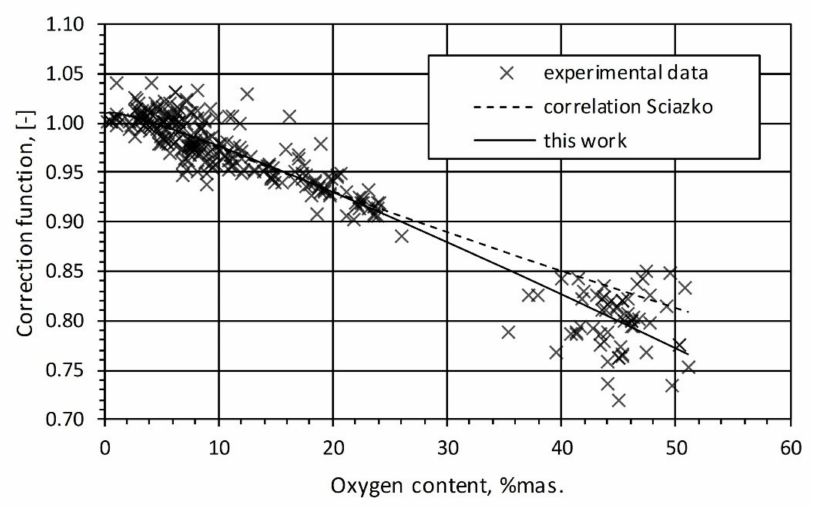
Figure 6. Comparison of experimental data with a new (Equation (5)) and former [22] correlation on enthalpy of formation.